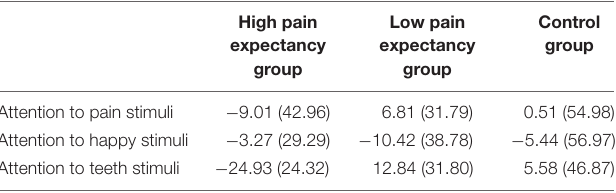
TABLE 3 | Means and SDs of attention index among High Pain Expectancy group, Low Pain Expectancy group, and Control group.